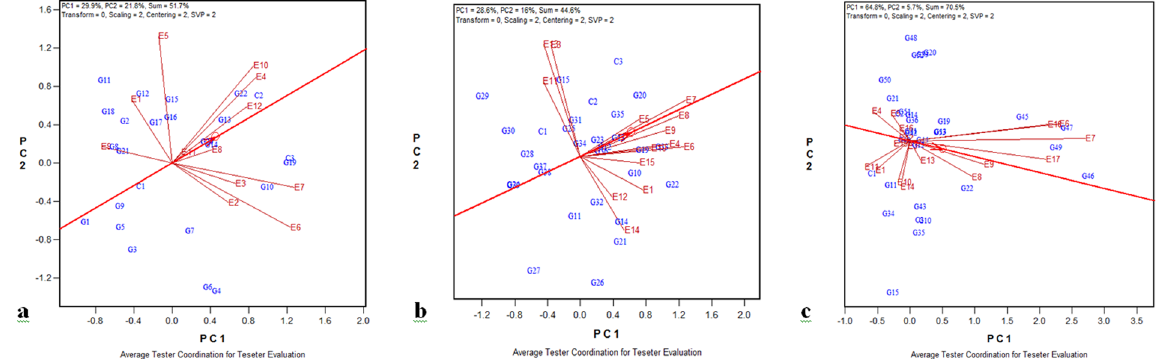
Figure 1. Association among the test environments and distance from the ideal genotype, based on the average environmental coordinate (AEC), considering stability and adaptability of rice genotypes evaluated across saline and alkaline environments for grain yield in ( a ) 2011, ( b ) 2012, and ( c ) 2013 growing seasons.